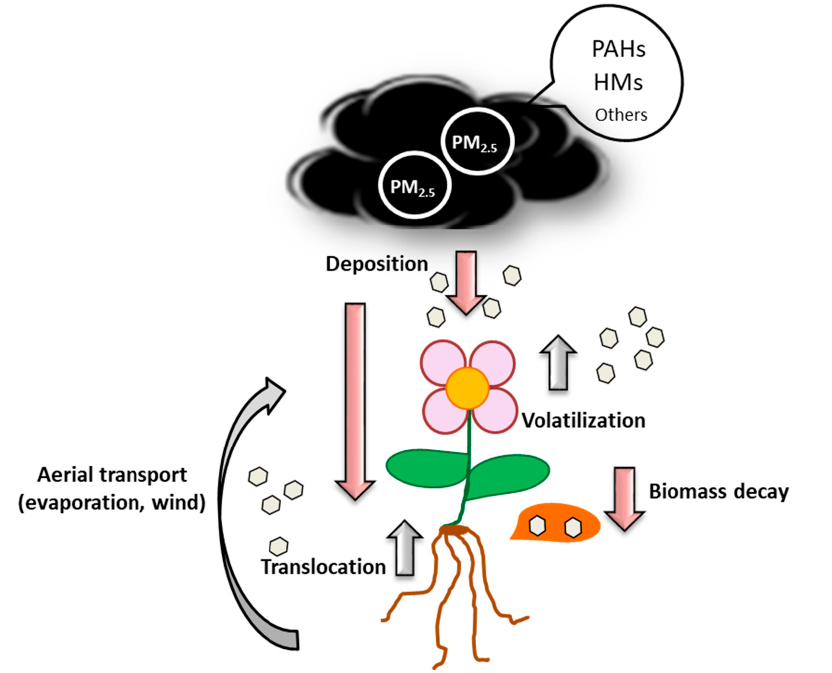
Figure 2. Schematic representation of the processes involved in the air–soil–plant mobilization of PMs (modified from [78]).